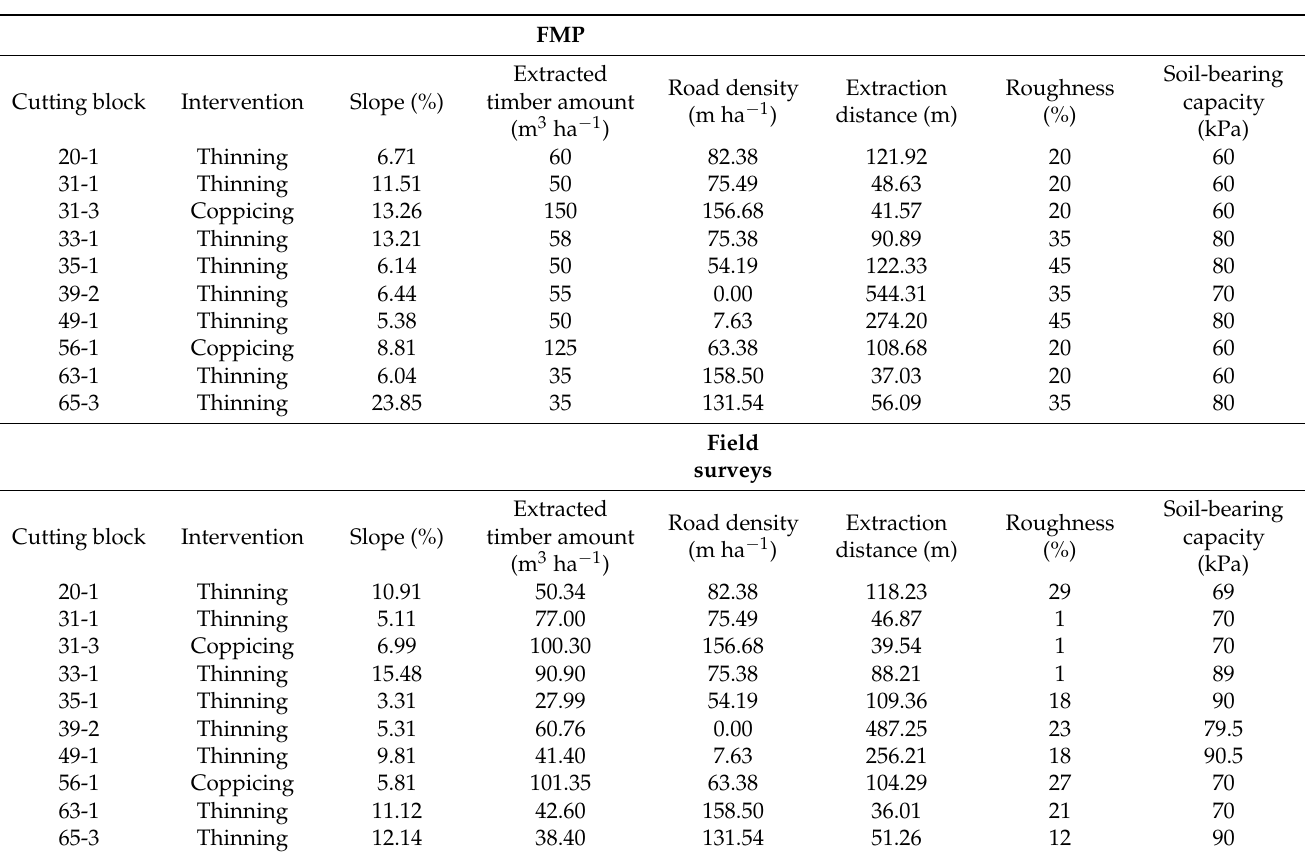
Table 3. Values of the six variables used for the GIS-AHP procedures were calculated from FMP data and from the field surveys carried out in the present